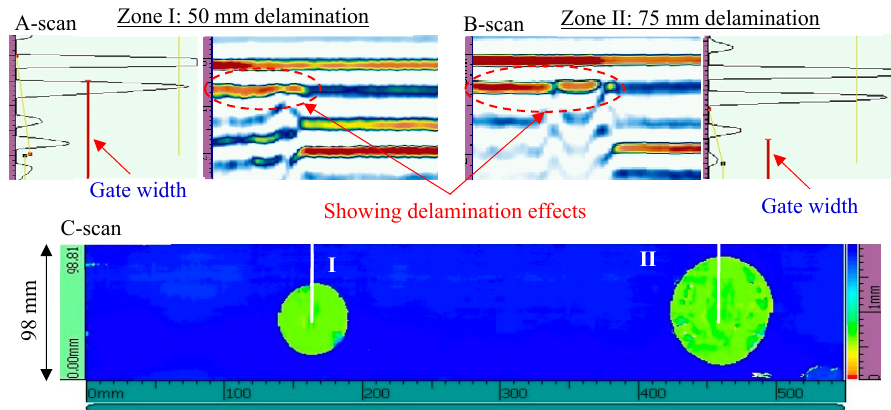
Figure 7. NDT results of the second inspection area on the cross-ply [0/90] 2s CFRP composite plate: 50 mm delamination and 75 mm delamination.